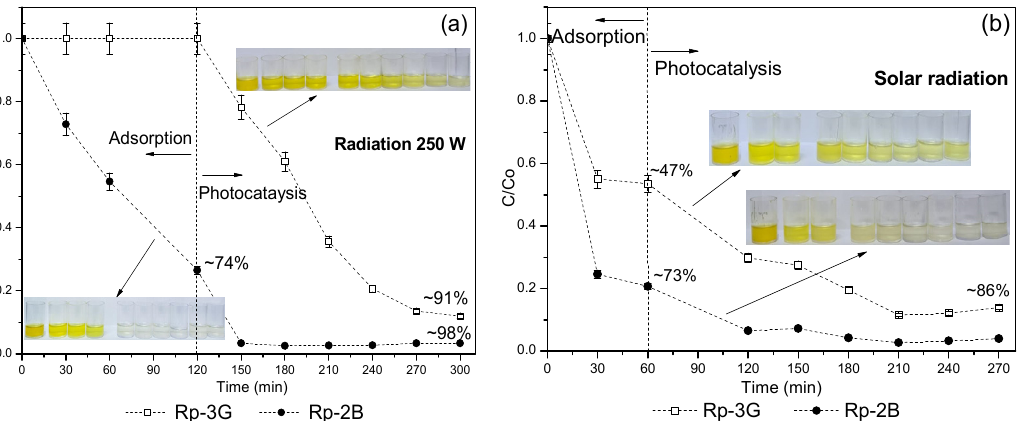
Figure 4. Results of the discoloration test using the industrial effluent: ( a ) artificial radiation (250 W vapor lamp) and ( b ) solar radiation. Error bars represent the standard deviation of measurements for the tests.